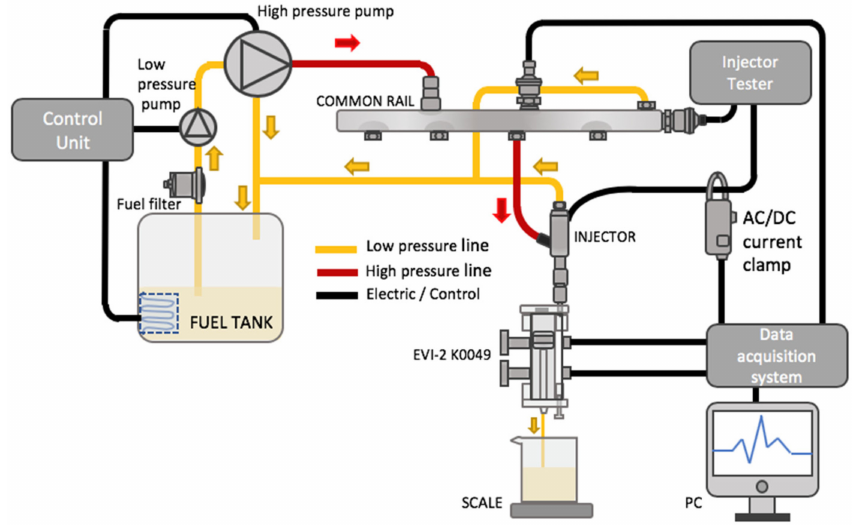
Figure 1. Schematic diagram of the experimental